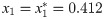
Evolutionary branching and evolutionary murder of predator species.(a) Traits coevolution plot when a2 = 2.21. The vector fields obtained from deterministic Model (9) indicate directions of coevolution of traits x1 and x2. The black curve and red curve indicate respectively isoclines of traits x1 and x2. The solid curves indicate evolutionarily singular strategies which are evolutionarily stable, while the dashed curve indicates evolutionarily singular strategy which is not evolutionarily stable. The grey region is feasible phenotype space, in which predator-prey coevolution can occur. (b) Pairwise invasibility plot (PIP) for fixed prey strategy x1=x1*=0.412. (c) Mutual invasibility plot (MIP) for fixed prey strategy x1=x1*=0.412. (d) Simulated evolutionary tree obtained through simulation of Models (9) and (29) with initial condition (x1, x2) = (0.3, 0.8) and a2 = 2.21. (e) Equilibrium population density of prey species along the coevolutionary trajectory. (f) Equilibrium population densities of predator species along the coevolutionary trajectory. At evolutionary time τ2, the equilibrium population density of predator 1 becomes zero. The red curve indicates total equilibrium population density of the two predator species. Parameter values: k = 0.01, b = 0.25, c = 0.001, μ1 = μ2 = μ21 = μ22 = 0.03, σ1 = σ2 = σ21 = σ22 = 0.03. The other parameter values are the same as described in Fig 1.